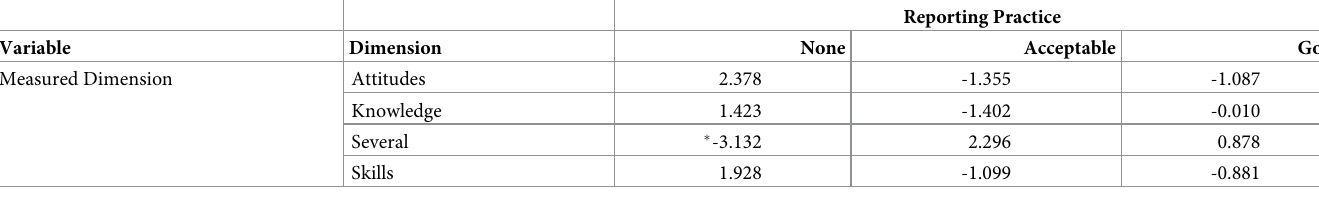
Table 8. Standardized residuals from post hoc analyses on Pearson’s Chi-squared